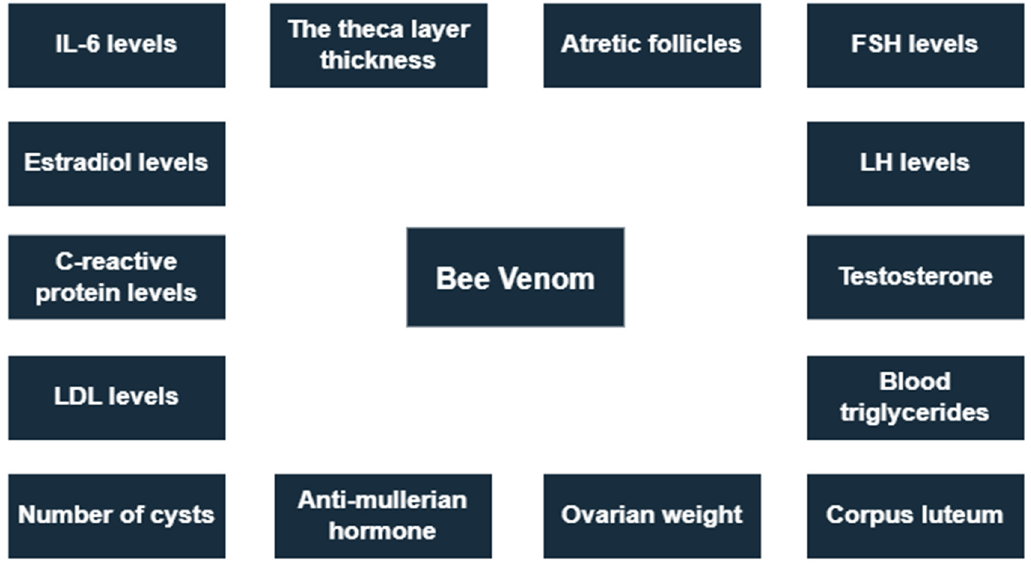
Figure 4. Bee venom affected parameters related to PCOS